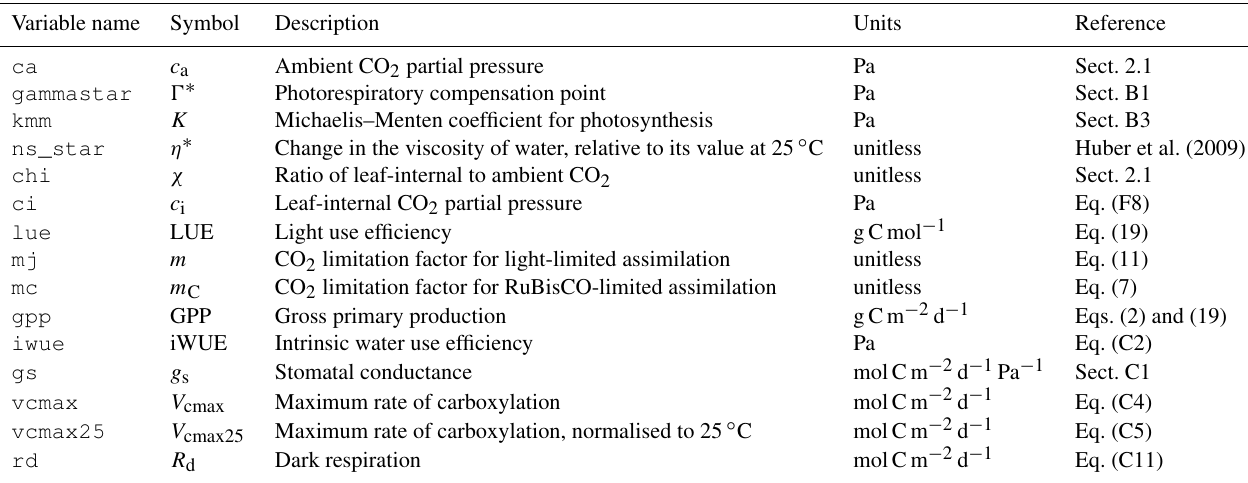
Table A3. Variables returned by the function rpmodel() . Variable names correspond to the named elements of the list returned by the rpmodel() function call. Symbols correspond to their use in this